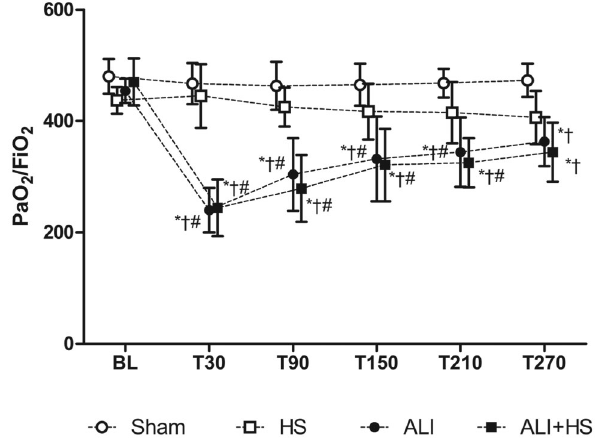
Figure 2 - Changes in the PaO 2 /FiO 2 ratio in the control (Sham and HS) and acid-lesion (acute lung injury and AI + hypertonic saline) groups. *: p o 0.05 compared with TB; w : p o 0.05 compared with the Sham group; #: p o 0.05 compared with the hypertonic saline